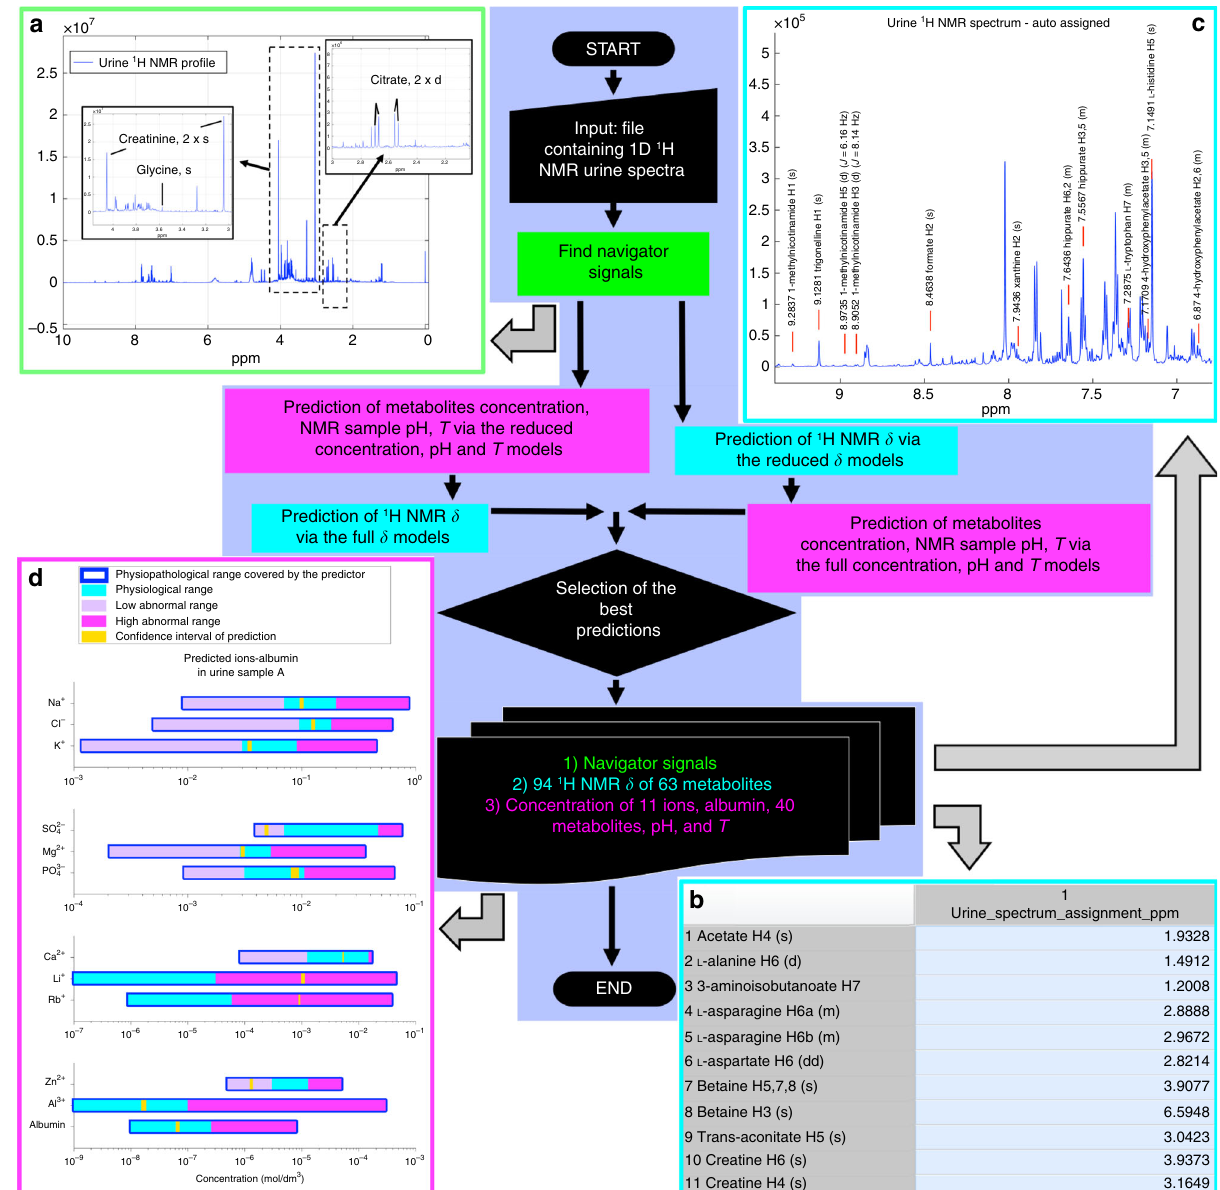
Fig. 4 Flowchart of the shift and concentration prediction. The fl owchart of the algorithm is highlighted in purple. The algorithm starts a upon the decision of the user about the automated or manual identi fi cation of the fi ve navigator signals: 2 doublets of doublets (dd) of citrate, 2 singlets (s) of creatinine, and 1 singlet (s) of glycine. For citrate and creatinine speci fi c criteria are used (e.g., the J-coupling constants of the doublets as well as the peak intensity ratios), applied to all peaks detected in a scanned spectral area where each spin system is expected to resonate (Supplementary Table 1). Since no constraints can be applied for the detection of the singlet of glycine, an extra prediction model is employed that predicts the chemical shift ( δ ) of the glycine singlet based upon the δ of creatinine and citrate. The prediction ability of this model was tested in 1600 different urine samples and resulted in no mis-assignments of the glycine NMR signals 17 – 19 . Using as input the fi ve navigator signals, the algorithm initially employs the reduced models (based on the fi ve navigator signals) to estimate the metabolites/ions concentrations, pH, T , and then predict the δ values for the other metabolites. Afterwards, the algorithm fi rstly predicts the δ values, and then concentrations, pH, and T are estimated from the former. The two routes result in two predicted δ values for each signal (i.e., δ reduced and δ full ), from which, according to speci fi c selection criteria, the best results are chosen (more details in the Methods section). b The output of the algorithm consists of the 94 1 H NMR signals of 63 metabolites and c of a fi gure for each urine NMR spectrum, where the predicted δ of each signal along with its multiplicity is reported. d Moreover, one extra fi gure is exported comparing the predicted concentrations of 11 ions and albumin with the normal clinical range for male/female adults (based upon Mayo Clinic, www.MedlinePlus.gov and the reference guides of the laboratories that performed the clinical analyses in the present study). Two extra fi les contain the predicted concentrations of 11 ions and albumin, pH, and T values, and the estimated concentration values of 40 metabolites,